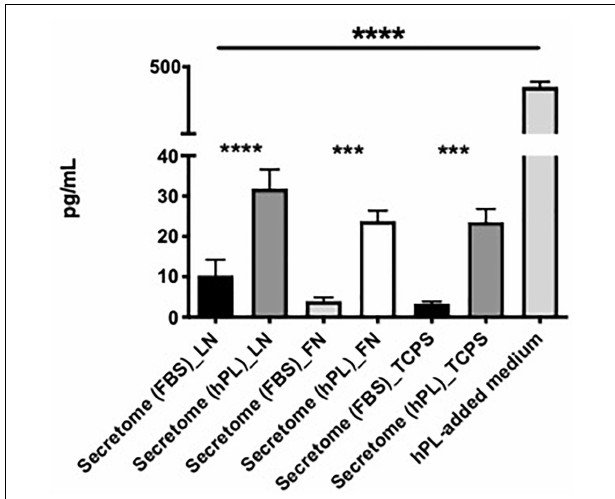
FIGURE 8 | hPL–hADSC show enhanced brain-derived nerve factor (BDNF) secretion. Evaluation of BDNF concentration (pg/ml) in hADSC-conditioned medium (secretome) on LN, FN, or TCPS. Both supplement media (FBS and hPL) were tested and compared according to the ECM-coating condition. BDNF concentration was evaluated in hPL-added medium alone (without cells), too. Three biological and technical (each one in duplicate) repeats were assessed. One-way ANOVA with Tukey’s multiple comparison tests was used for assessing statistical significance among the examined groups (* p < 0.05, ** p < 0.01, *** p < 0.001, **** p <